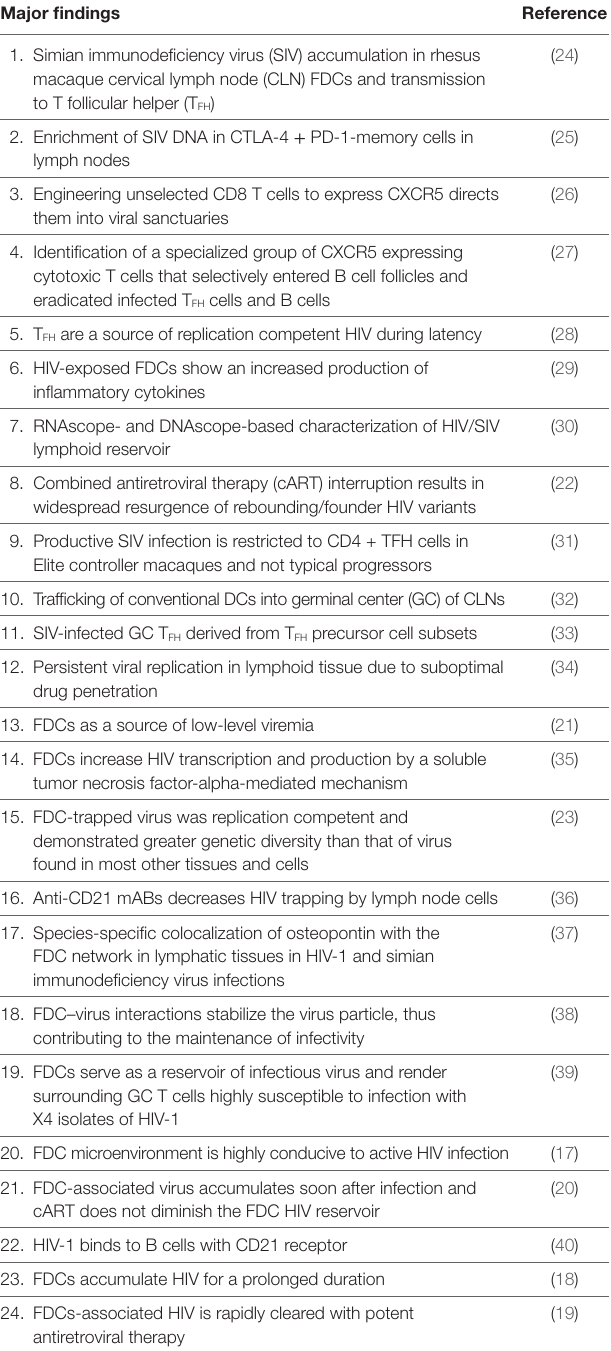
TABLe 1 | Advances in follicular dendritic cell (FDC)-related human immunodeficiency virus (HIV)